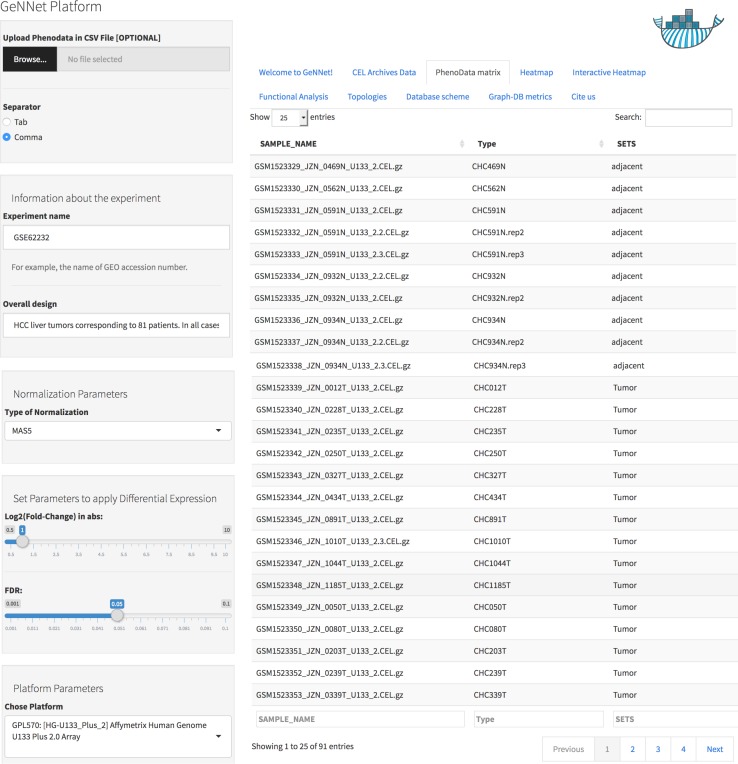
User-friendly interface in GeNNet.Left-hand side showing parameters settings and right-hand side showing some tabs highlight PhenoData matrix uploaded.